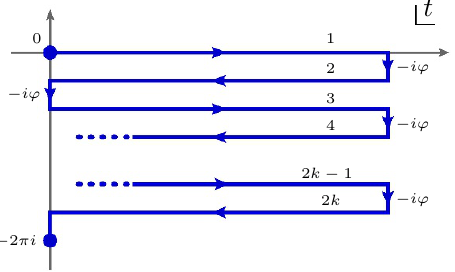
(equal separations) k